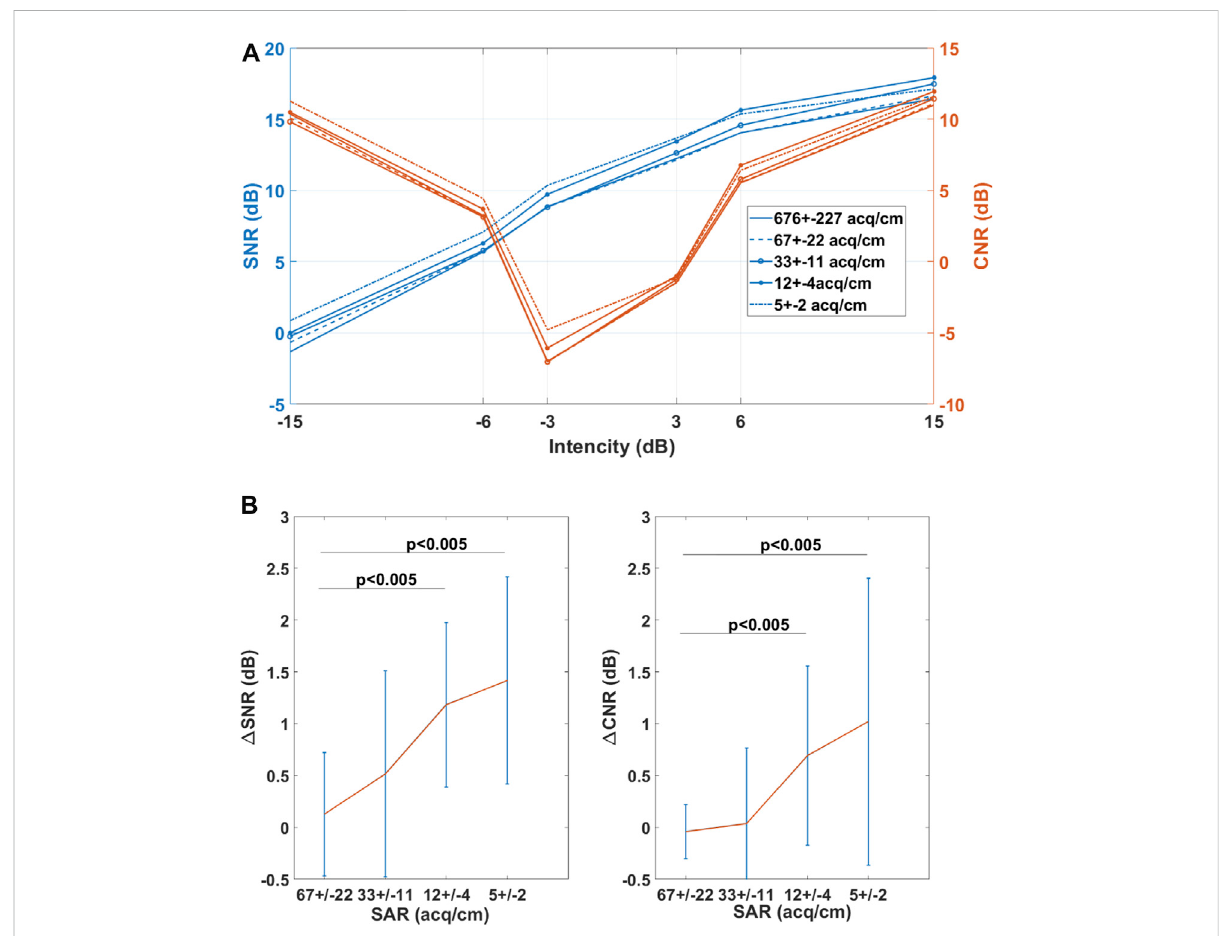
FIGURE 7 Impact of SAR on SNR and CNR (A) SNR and CNR dependency on echogenicity (B) The mean value of paired difference in SNR ( Δ SNR SAR =SNR SAR=676 – SNR SAR )andCNR( Δ CNR SAR =CNR SAR=676 – CNR SAR )values.Theredlinerepresentsthemeandifferencewhiletheblueline indicates the 95% con fi dence